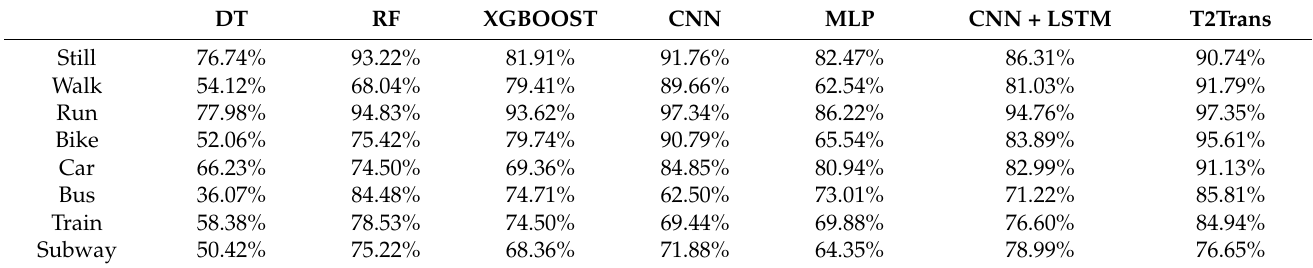
Table 4. The precisions of different transportation mode detection methods using different algorithms on the HTC